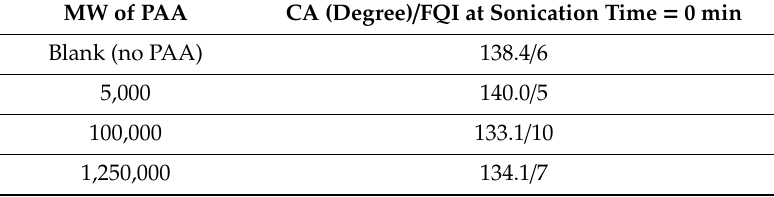
Figure 3. Two distinct contact angles on the forming hydrophobic film within 24 h of sol aging time at the ratio of the iso-BTMS/TEOS = 1.39; where ( a ) film areas, and ( b ) hole area. Table 3. Static water CAs of the hydrophobic film with various molecular weights of poly-acrylic acid (PAA). MW of PAA